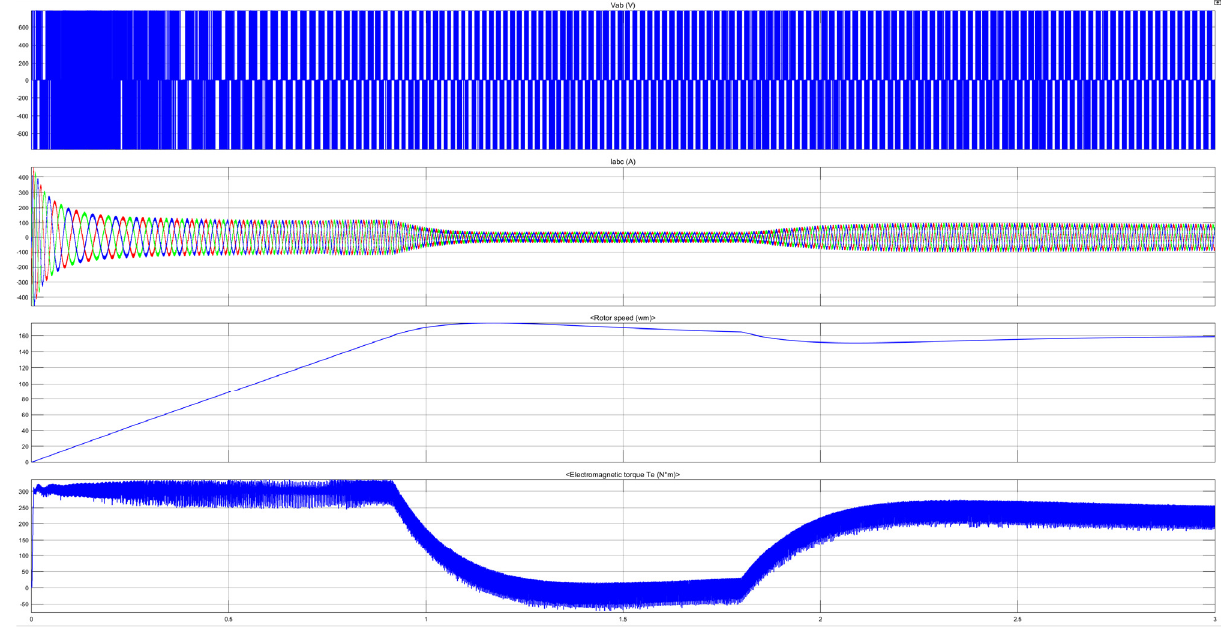
Figure 3. Diagrams of voltage changes between two phases, electric current in three phases, angular speed of motor and torque with the change of speed and load.